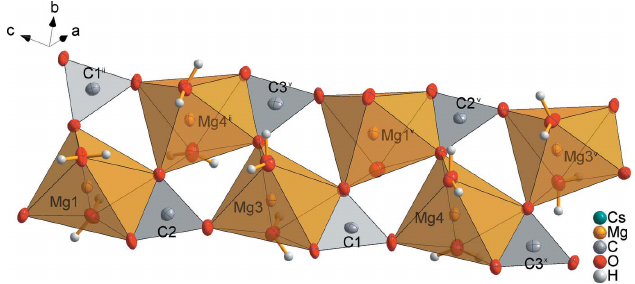
Figure 2 Double chain built up from octahedra around Mg1, Mg3 and Mg4 and carbonate units. [Symmetry codes: (ii) x (cid:4) 1 z (cid:4) 1 ; ( x ) x + 1, y , z (cid:4) 1.] 2